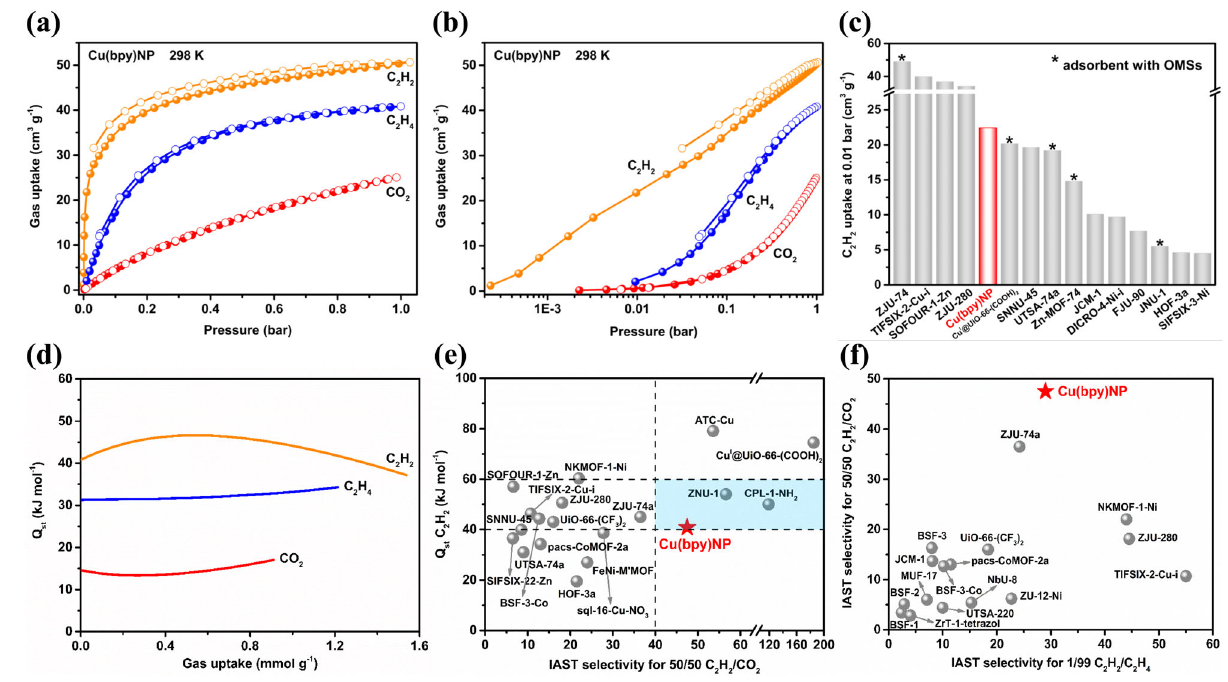
Fig. 2 | C 2 H 2 , CO 2 , and C 2 H 4 sorption in nitroprusside-based Hofmann-type MOFs. C 2 H 2 , CO 2 , and C 2 H 4 adsorption isotherms a in linear form and b in loga- rithmic form of Cu(bpy)NP at 298K; c comparison of C 2 H 2 uptakes with